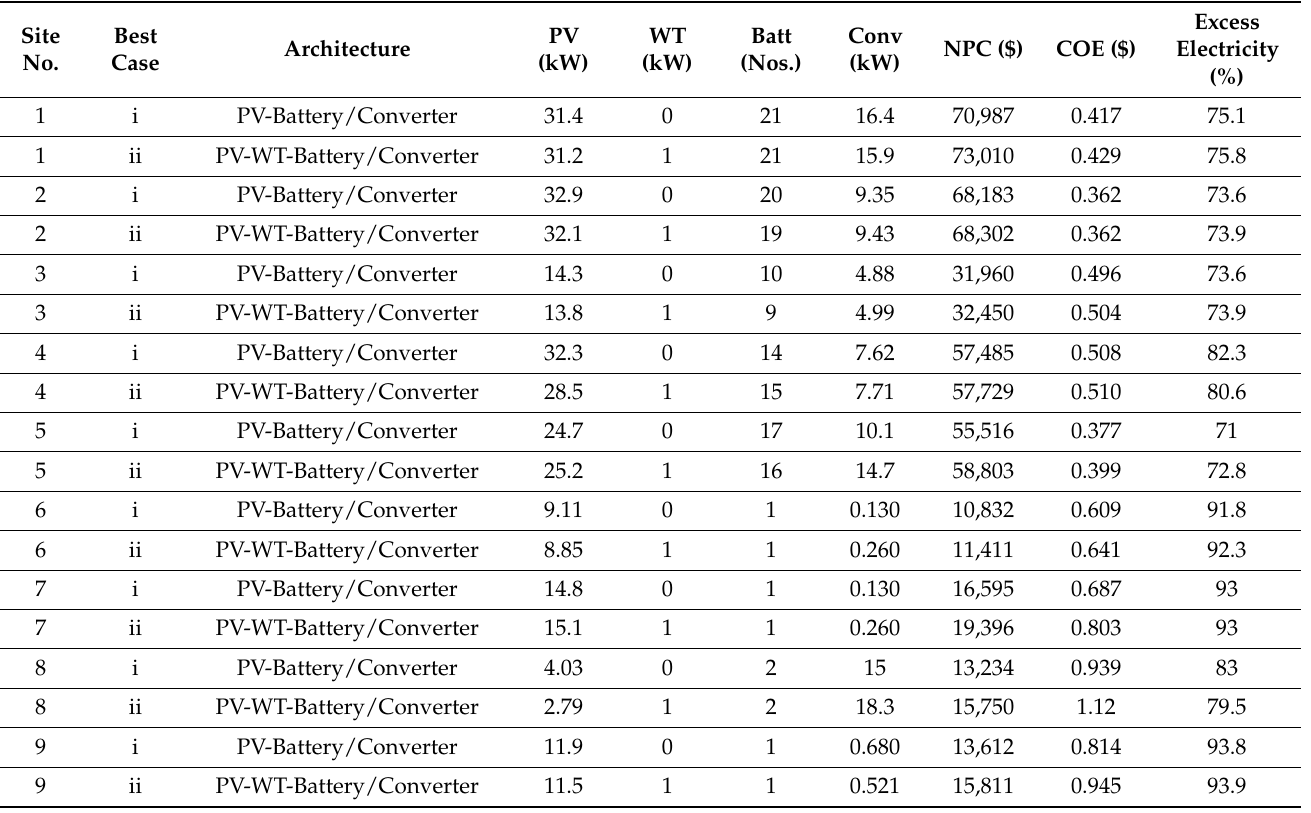
Table 2. Results of HOMER Pro for 12